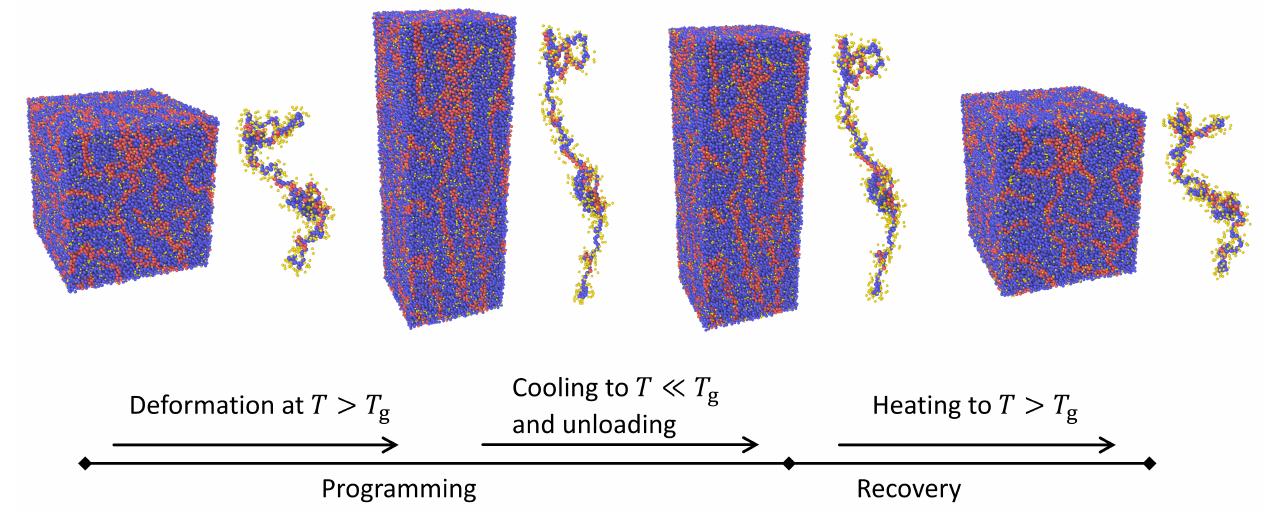
Figure 4. A shape memory cycle for the present bead-spring copolymer model. The sample is first deformed at a temperature above its glass transition, T g . Then it is cooled down to a temperature below T g followed by unloading. The sample first deforms back slightly due to its energetic elasticity but the major part of deformation is stored as it is connected to entropic elasticity, the latter becoming active at temperatures above T g . Therefore, shape recovery takes place only if the sample is heated to a temperature T > T g